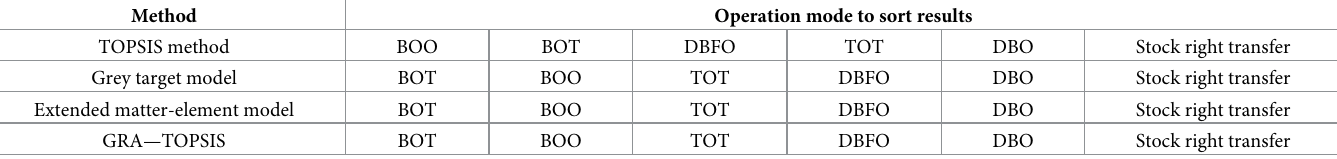
Table 7. Comparison of the results of different